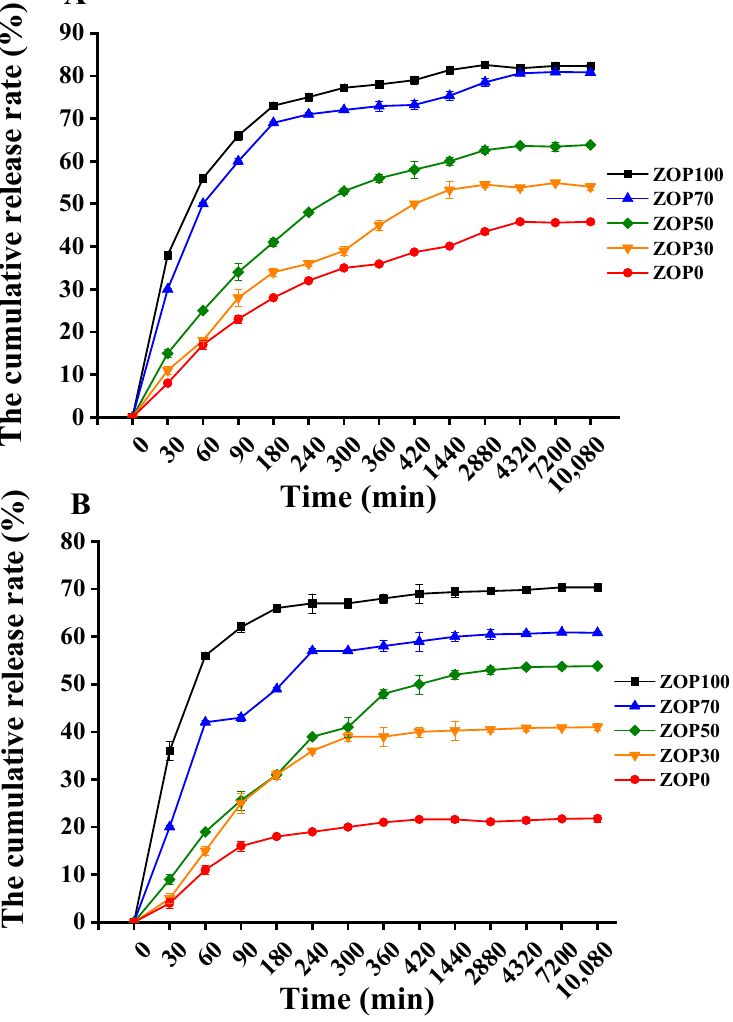
Figure 9. The cumulative release rate (%) of different hydrogels in pH 1.2 PBS ( A ); the cumulative release rate (%) of different hydrogels in pH 7.4 PBS ( B ).